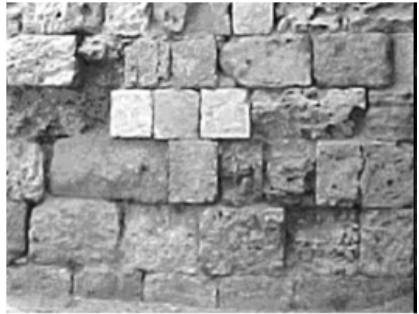
Figure 11. Photograph the investigated masonry in the Medieval Fortifications of Rhodes.